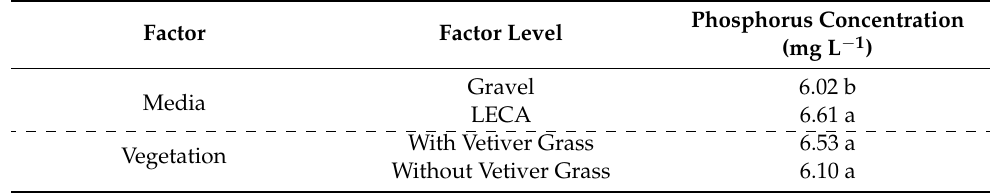
Table 4. Total phosphorus concentrations on BTFs